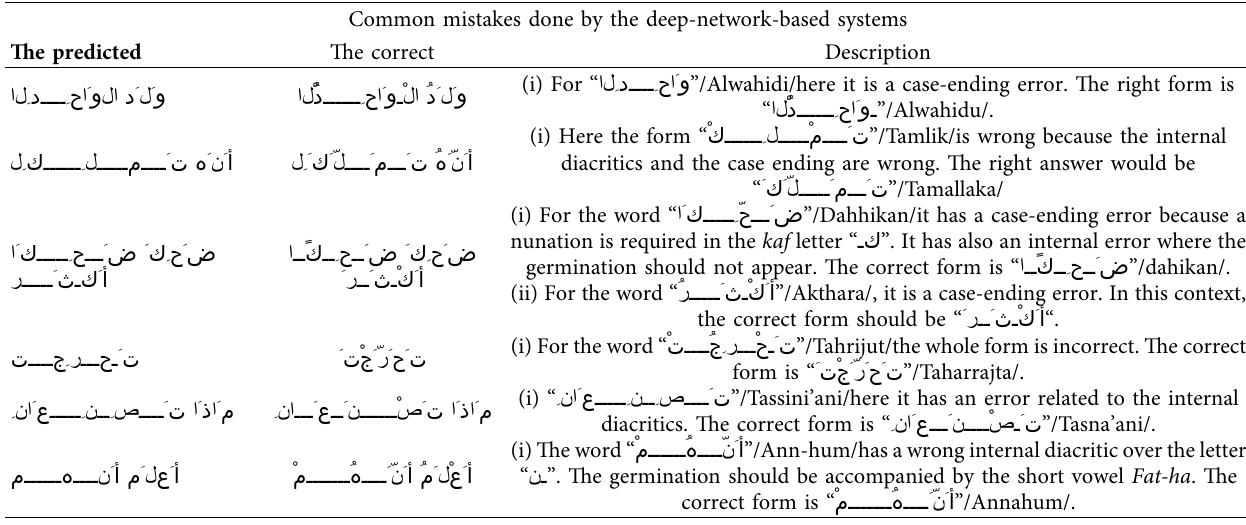
Table 7: Common mistakes done by the deep-net-based systems. Common mistakes done by the deep-network-based